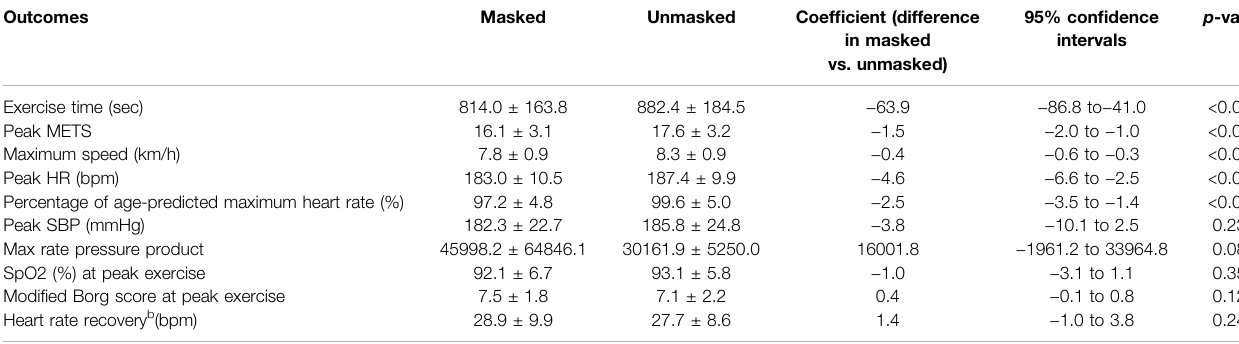
TABLE 2 | Subject-speci fi c random-intercept models a . Outcomes